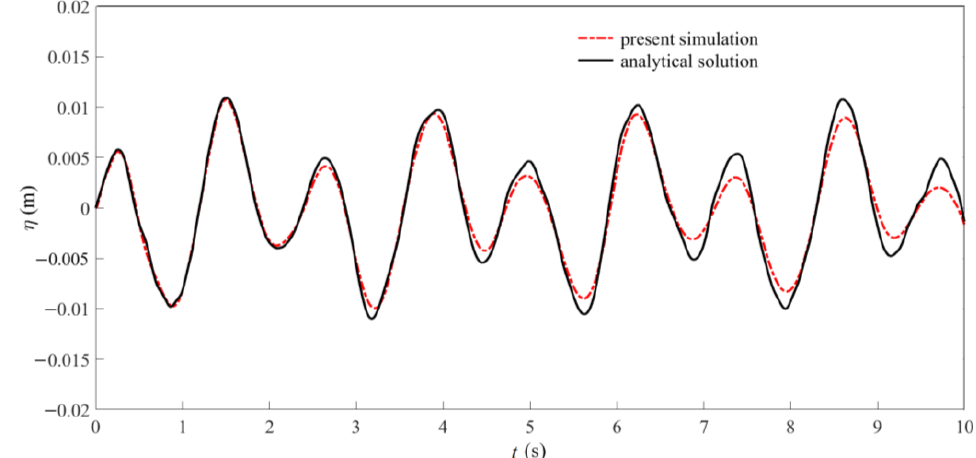
Figure 2. Comparison of the time history of free surface elevation at y = 0 between the results of the present simulation and analytical solution from Faltinsen [34].